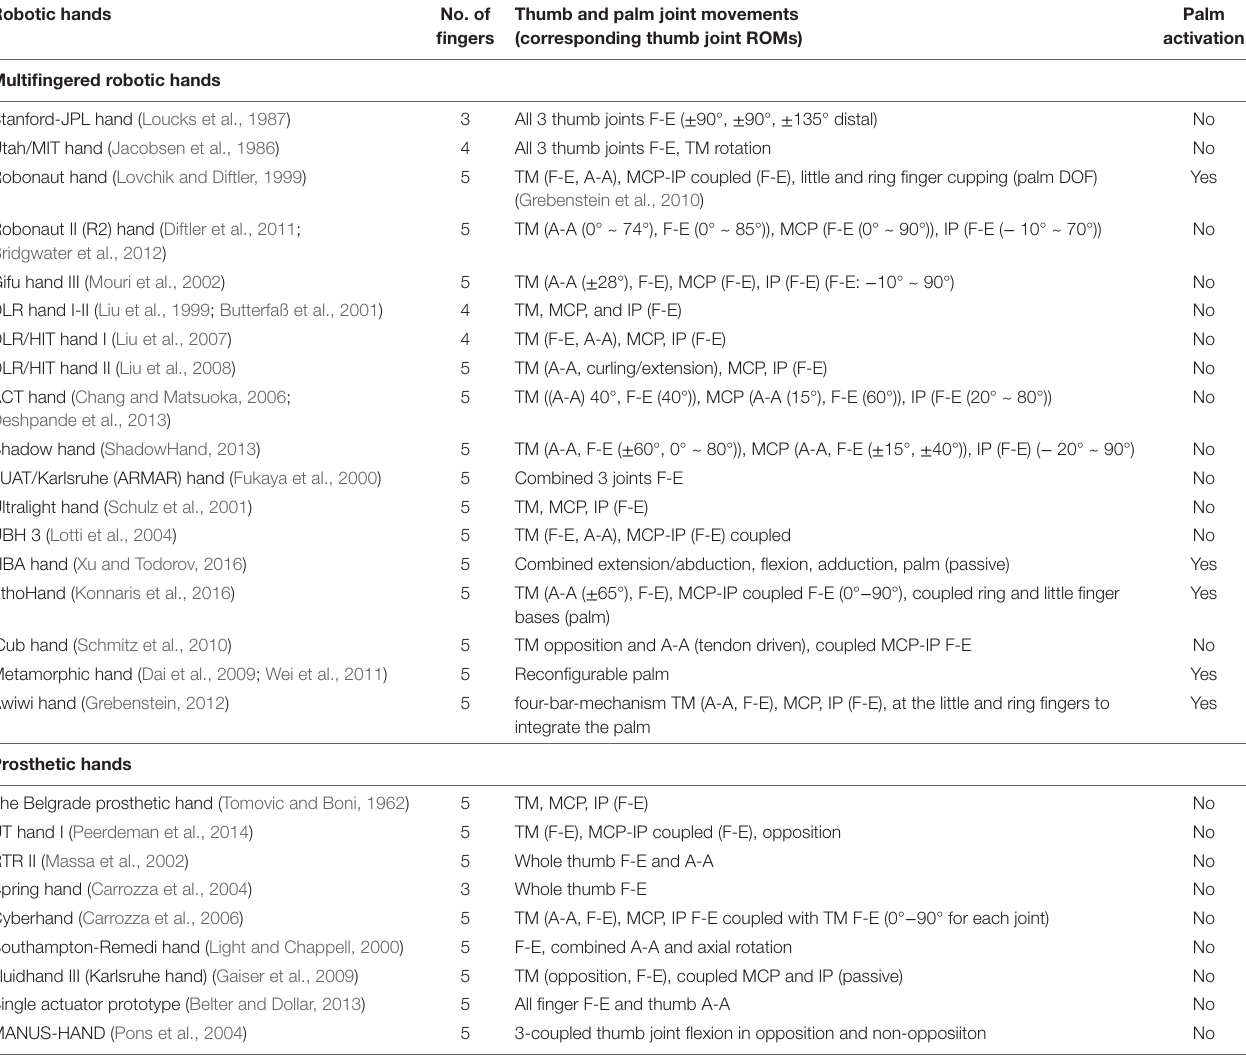
TABLe 3 | Robotic thumb comparison in multifingered hands. Robotic hands No. of